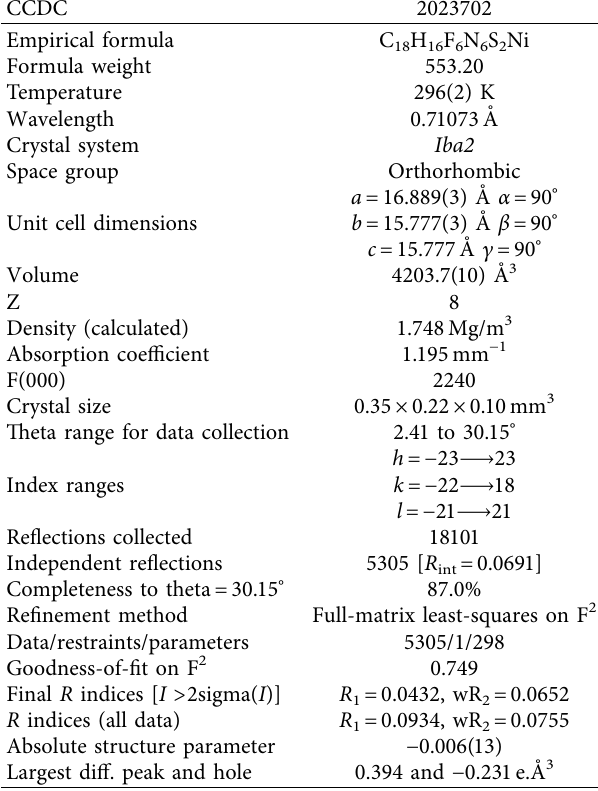
Table 1: Crystal data and structure refinement for NiL